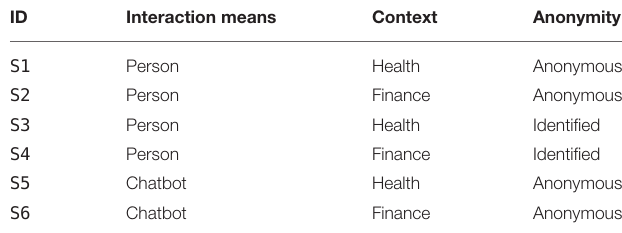
TABLE 2 | Scenarios used in the